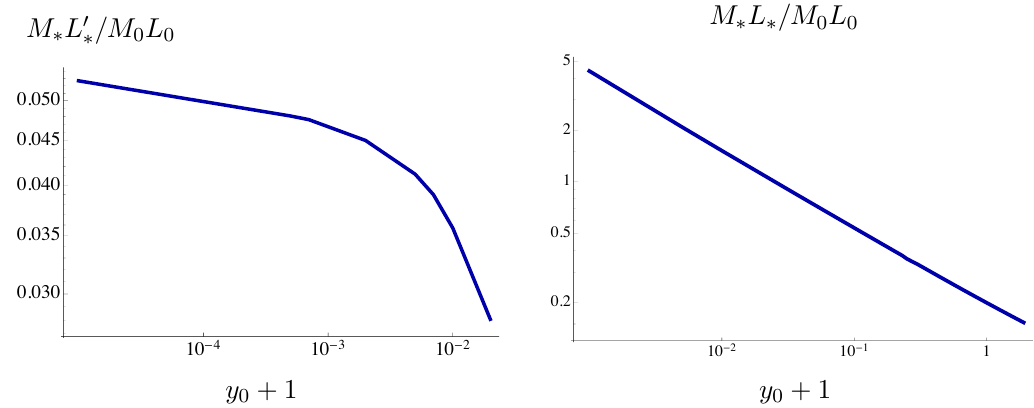
Figure 9 . Comparison of the emergent IR scales extracted from the behavior of the dilaton and of the quark-antiquark